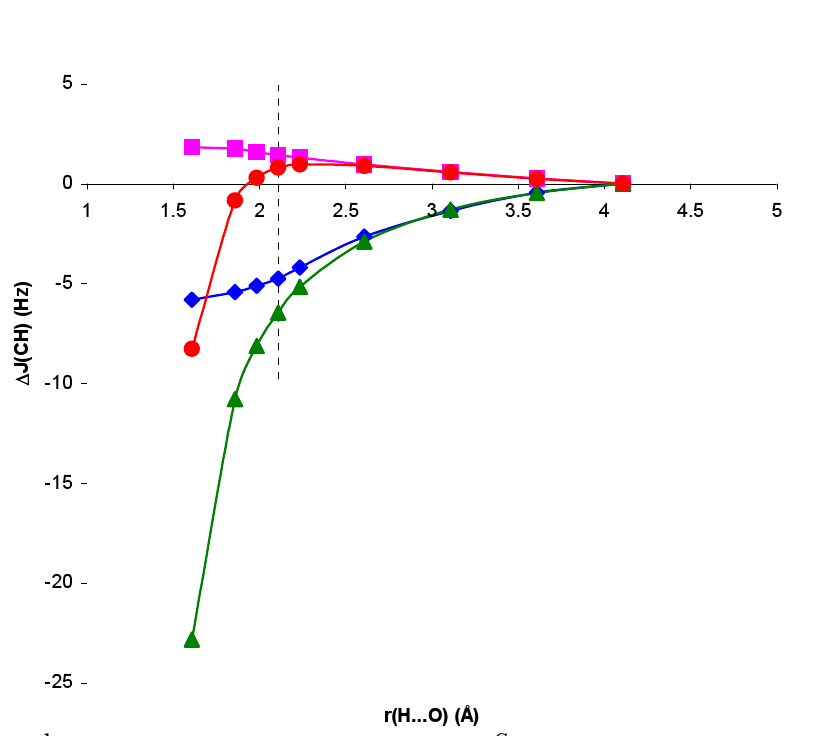
Figure 1. Change in 1 J(CH) for the NCH...OH field, ∆ J E , with respect to 1 J(CH) for the isolated NCH molecule, as a function of the H...O distance, r(H...O). - (cid:88) - ∆ J E (RPA), - (cid:81) - ∆ J E (SOPPA), - (cid:86) - ∆ J C (RPA), - (cid:79) - ∆ J C (SOPPA). The dotted line indicates the equilibrium